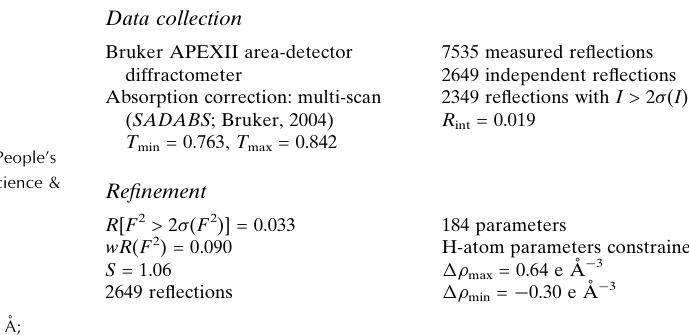
Bruker APEXII area-detector diffractometer